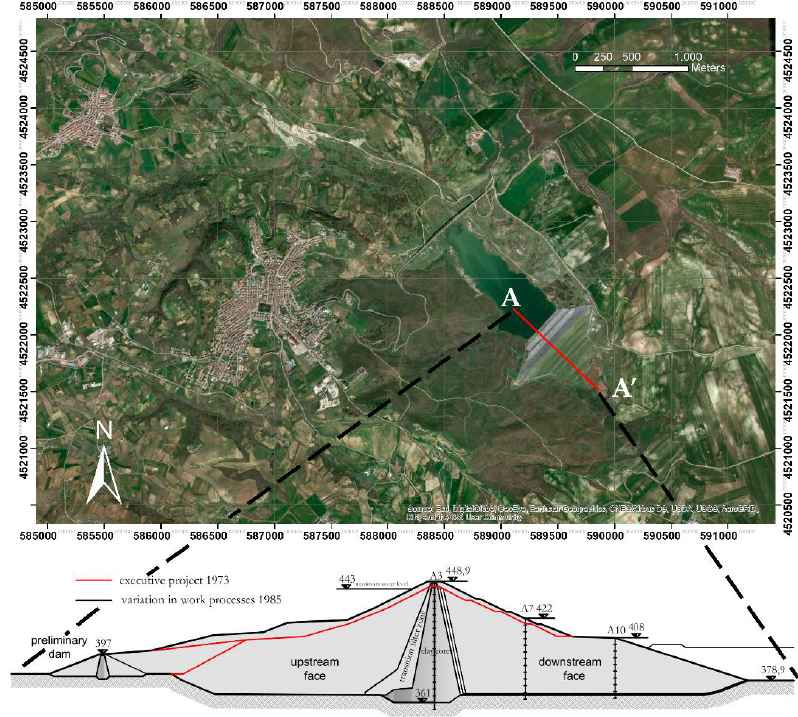
Figure 4. ( a ) Ortophoto of the Genzano di Lucania reservoir; ( b ) main cross section of the dam (modified in December 1985 from the initial configuration indicated by red lines.